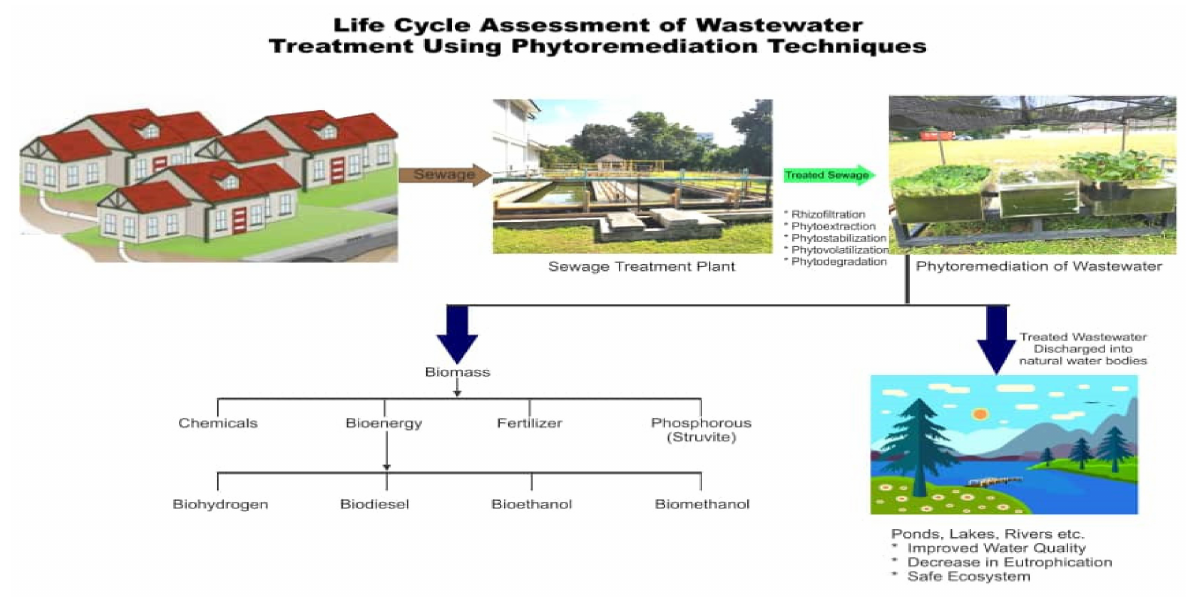
Figure 1. Lifecycle assessment of wastewater treatment using phytoremediation techniques.